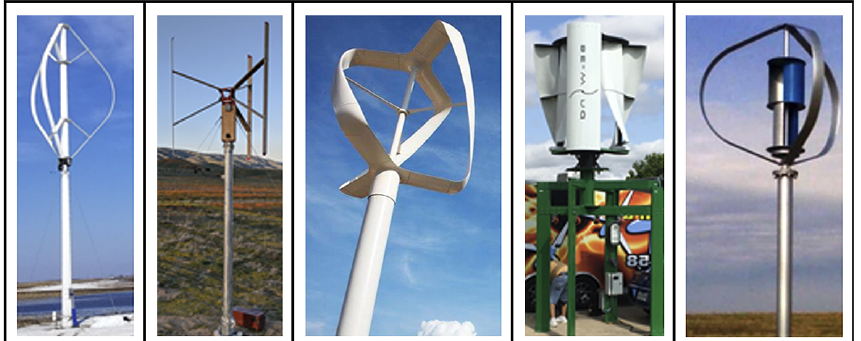
Figure 13. Common VAWT archetypes found on the current DWT market. From left to right: Darrieus Troposkien (photo credit: Chava Wind), H-Darrieus (photo credit: Xflow Energy), H-Darrieus with helix shape (photo credit: PRAMAC), Savonius (photo credit: BE Wind), combined Savonius–Darrieus (photo credit: